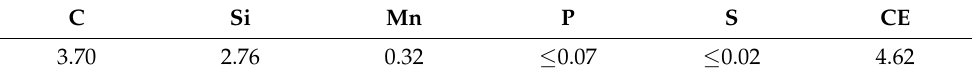
Table 1. Composition of the ductile cast iron in this experiment (wt %).